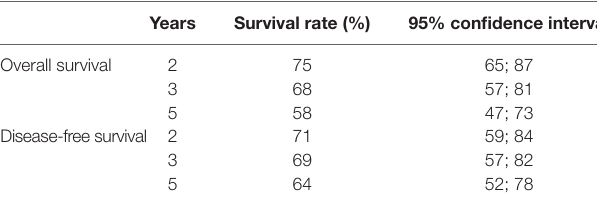
Table 6 | Kaplan–Meier estimates of survival for stages III and IVa.